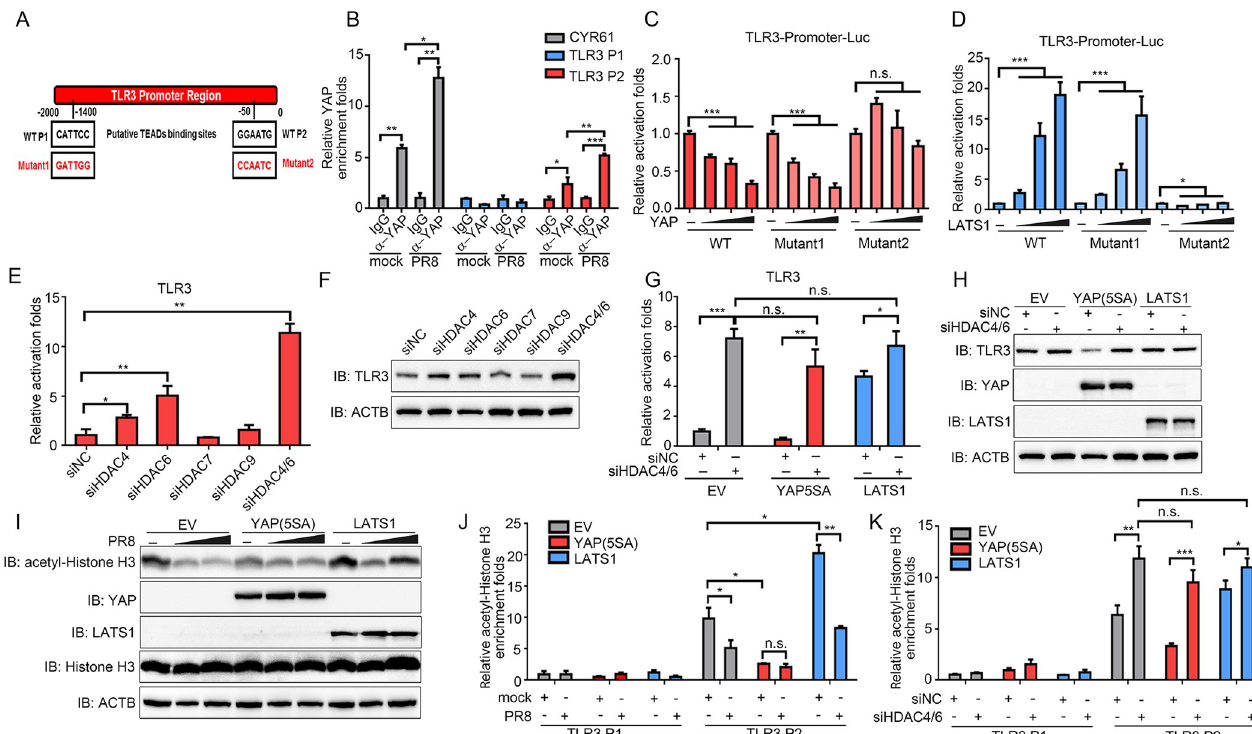
Fig 6. YAP/TAZ promote histone deacetylation in the TLR3 promoter region via HDAC4/6. (A) S chematic representation of the TLR3 promoter with the putative TEADs binding sites was shown. Corresponding mutation sites constructed in the luciferase plasmids were presented below. (B) A549 cells were infected with PR8 virus at an MOI of 0.01 or mock control for 12 hours. ChIP assay was then conducted using anti-YAP or normal rabbit IgG. Precipitated DNA was measured by qPCR using primers to amplify the indicated regions surrounding the putative TEAD-binding sites. (C, D) Luciferase reporter activities driven by wild type or mutants of the TLR3 promoters with overexpression of YAP (C) or LATS1 (D) were assessed. (E, F) A549 cells were transfected with indicated siHDACs. The expression of TLR3 was determined by RT-qPCR (E) and immunoblotting (F). (G, H) siNC or siHDAC4/6 was transfected into EV, YAP(5SA) and LATS1-overexpressing cells. TLR3 expression was measured by RT-qPCR (G) and immunoblotting (H). (I) Cells overexpressing of EV, YAP (5SA) and LATS1 were infected with mock control or PR8 virus at an MOI of 0.005 and 0.01 for 24 hours. Indicated protein expression levels were measured by immunoblotting. (J, K) EV, YAP(5SA) and LATS1-overexpressing cells were infected with PR8 virus at an MOI of 0.01 or mock control for 12 hours (J), or transfected with siNC and siHDAC4/6 (K). ChIP assay was then conducted using anti-acetyl-Histone H3 antibody or normal rabbit IgG. Precipitated DNA was measured by qPCR using primers to amplify the indicated regions on the TLR3 promoter. All experiments were repeated at least three times. Data in (B-E), (G) and (J-K) are presented as means ± SD. � p < 0.05, �� p < 0.01, ��� p < 0.001. n.s., not significant ( p >